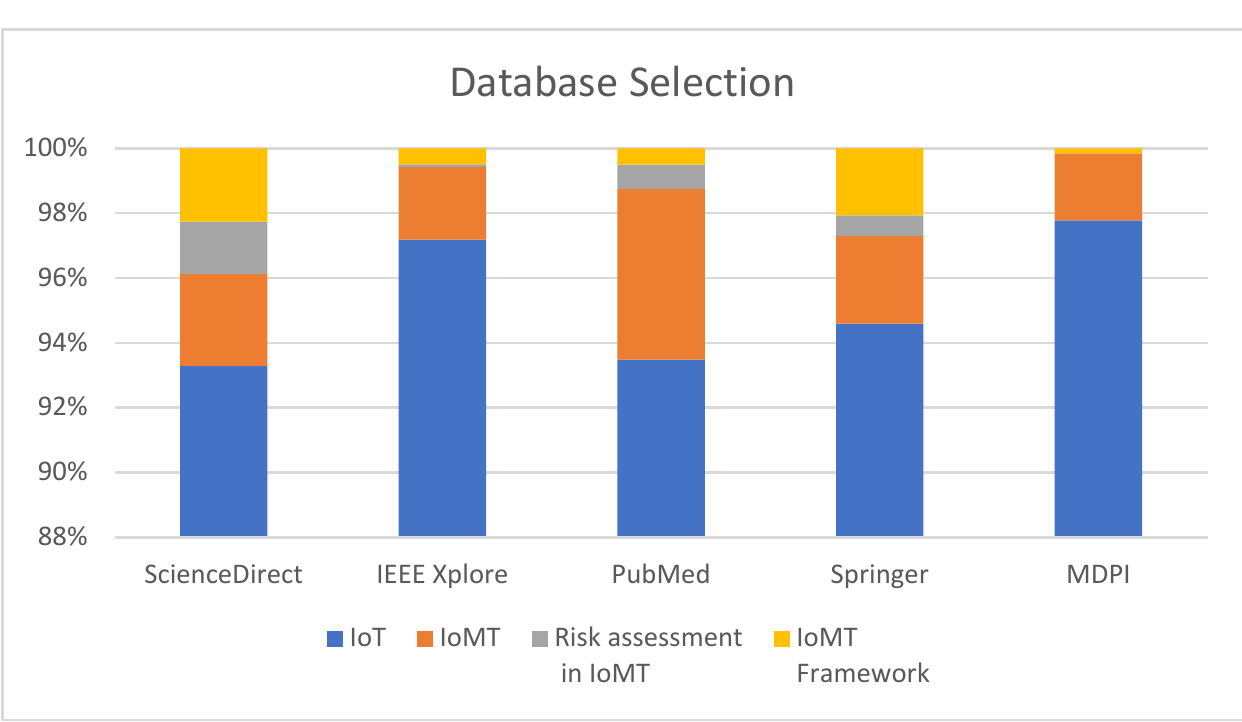
Figure 7. Database search selection.